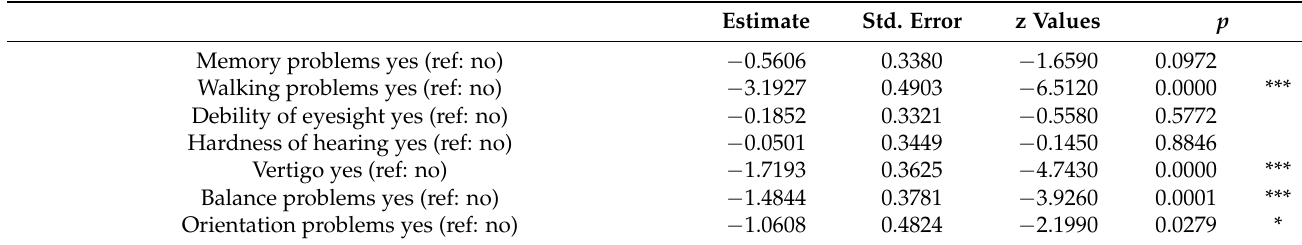
Table 3. Ordinal model of self-rated health regressing on several conditions in separate models controlling for sex, age, and education (data not shown); * p < 0.05, *** p < 0.001.